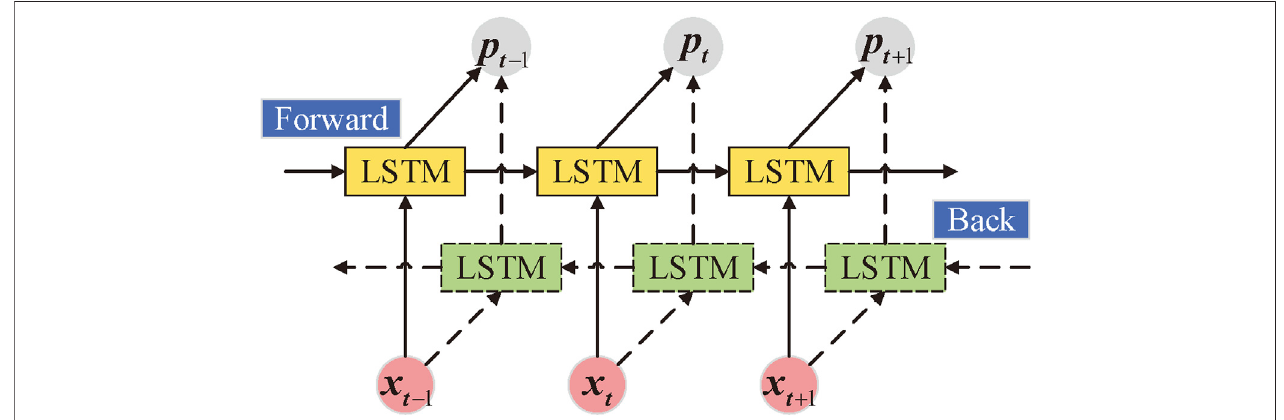
FIGURE 4 | Operating characteristics of the